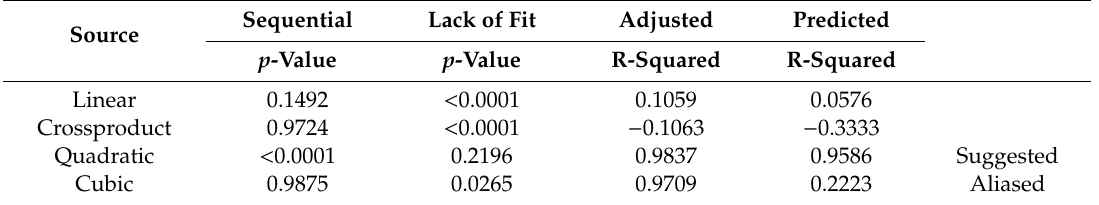
Table 7. ANOVA of regression model for tryptophan production by P. acidilactici TP-6.